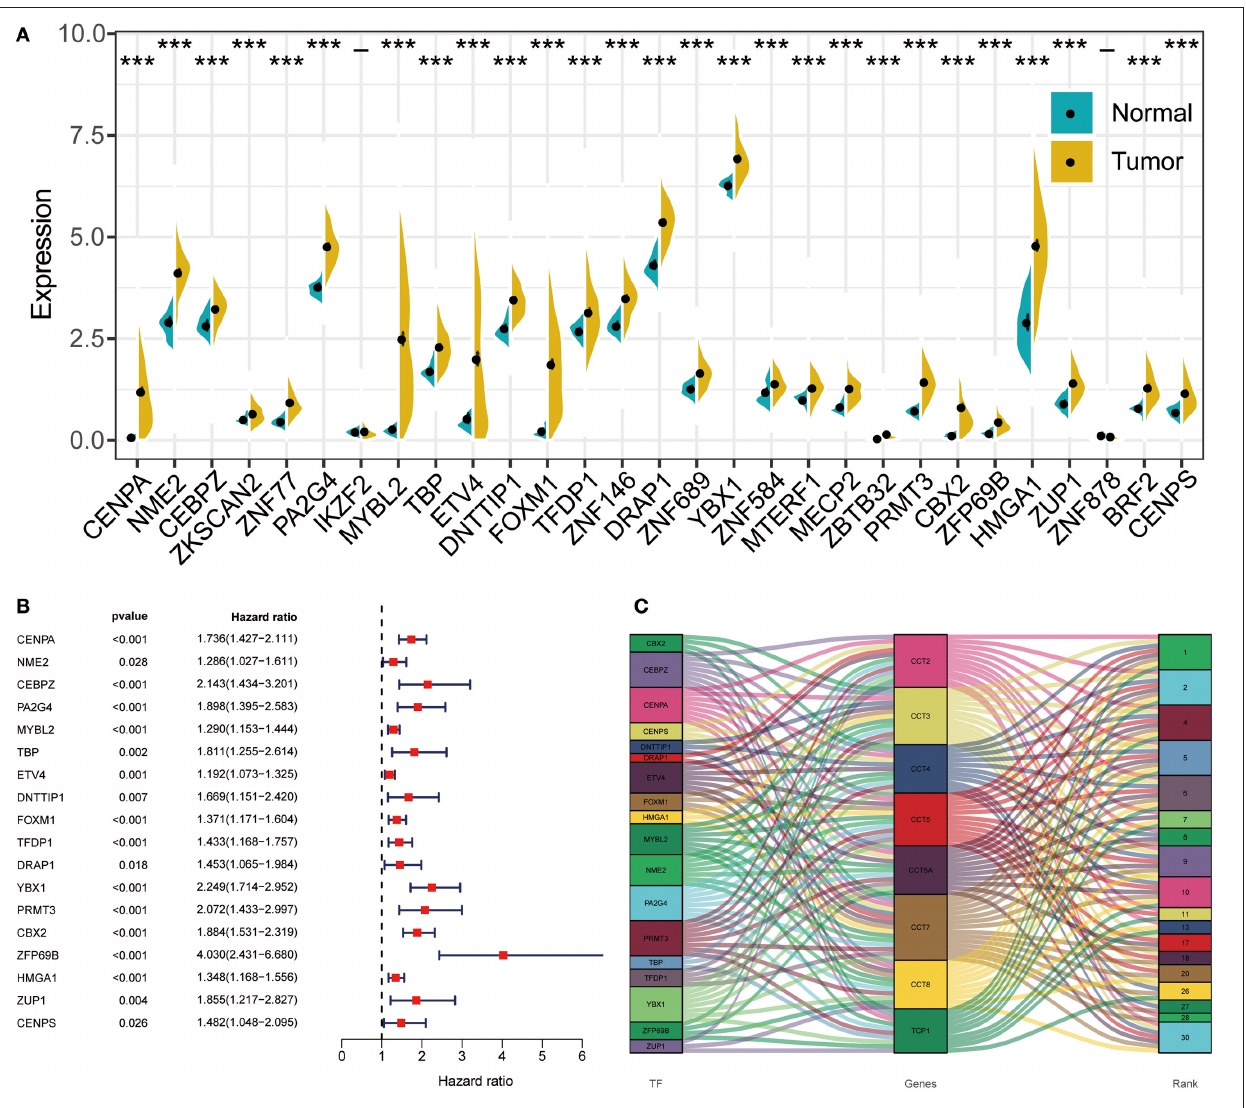
FIGURE 8 | The regulation network between transcription factors and CCT subunit genes. (A) Differentially expressed transcription factors in HCC tissues and normal tissue. * P < 0.05, ** P < 0.01, *** P < 0.001. (B) Univariate COX survival analysis of differentially expressed transcriptional factors in HCC. (C) Regulation network of CCT subunit genes and survival-related transcription